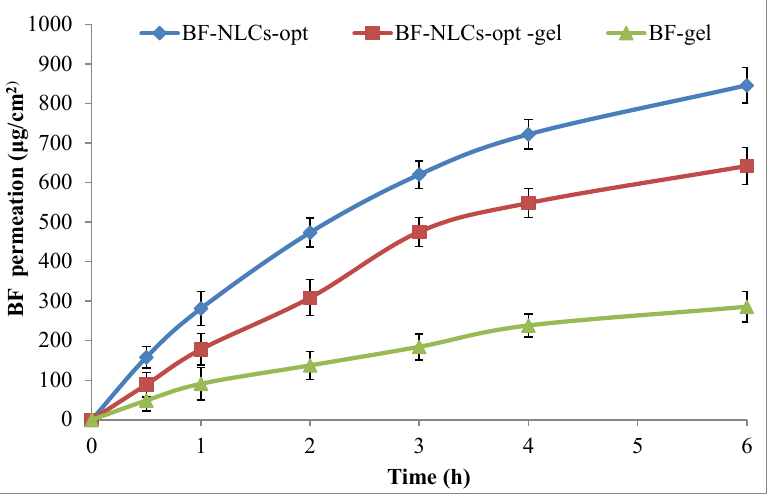
Figure 8. Permeation study profile of BF-NLCopt, BF-NLCopt gel, and BF-gel. Each study was performed in triplicate and data shown as mean ± SD. Comparison of permeation study of BF gel with BF-NLCsopt gel and BF-NLCs-opt. The significant differences observed at p < 0.001.